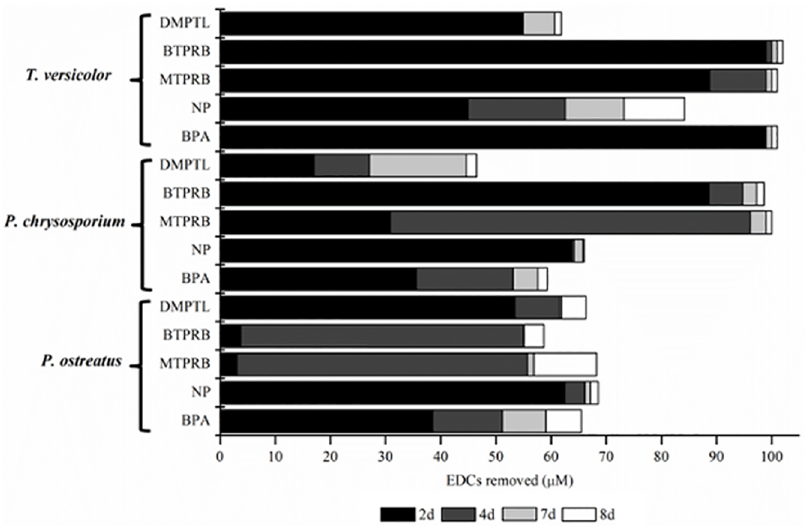
Fig 2. EDCs removed( μ M) by T . versicolor , P . chrysosporium and P . ostreatus after 2, 4, 7 and 8 days of treatment in rich medium (RM). SingleEDCs were appliedto the culture broth at 100 μ M, respectively. Standarddeviations from three replicates of each series of results were less than ±